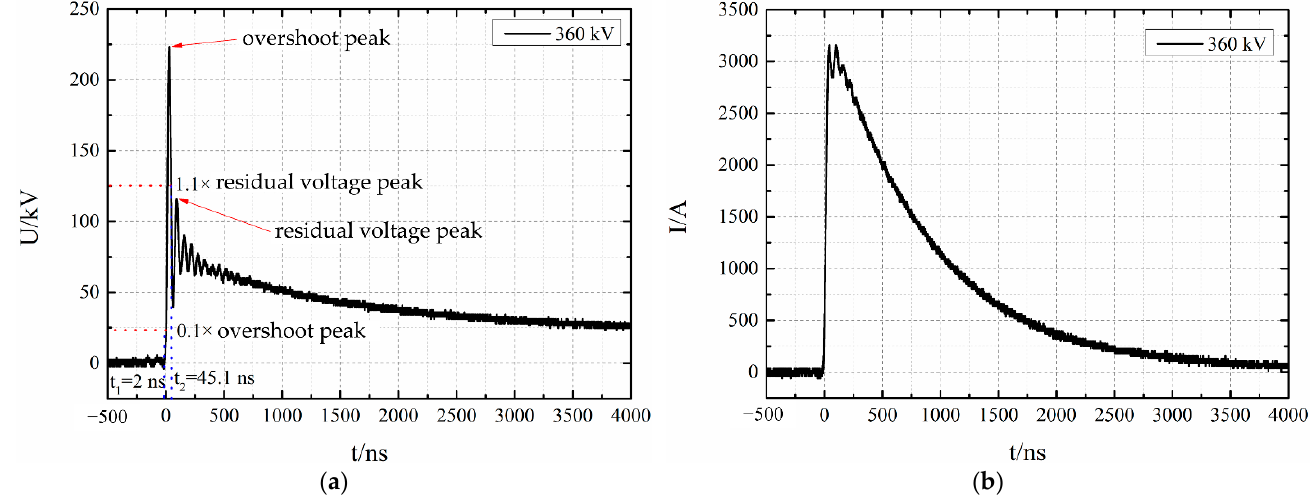
Figure 3. Typical waveform of voltage and current of arrester under power-off state: ( a ) Voltage waveforms; ( b ) current waveforms.